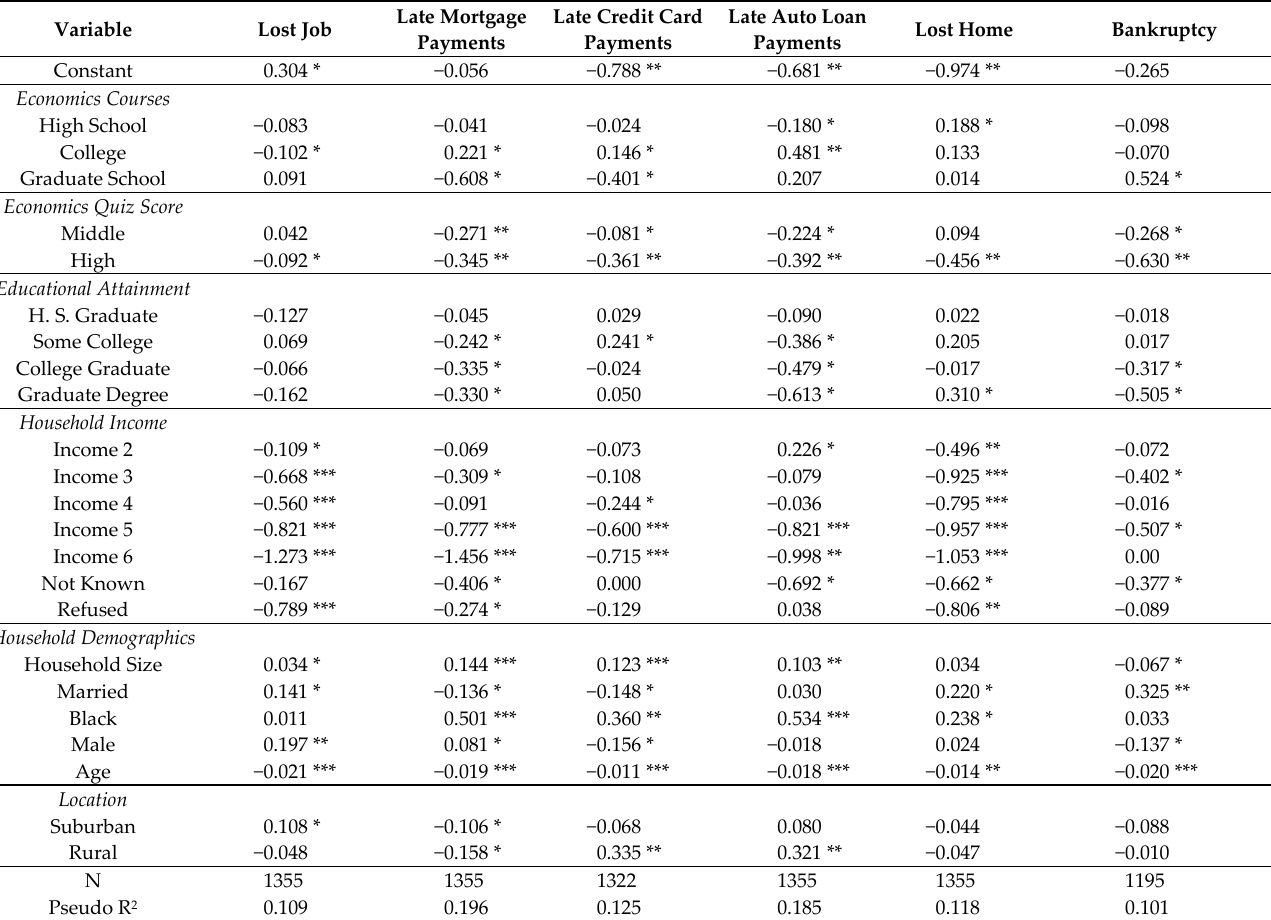
Table 6. Probit Results: Economic Literacy and the Financial Crisis’ Effects on Household Finances.